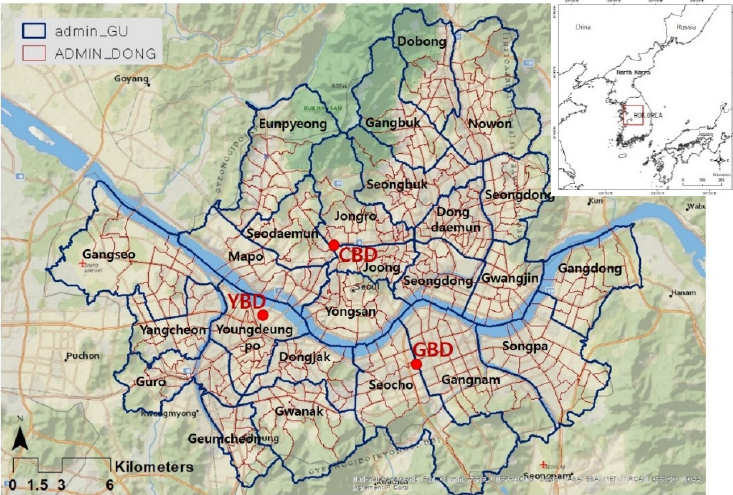
Figure 1. Map of Seoul. Note: CBD refers to a traditional business district. YBD indicates Yeoido business district, and GBD stands for Gangnam business district. These three districts are the main urban centres in Seoul [77]. The variable “admin_GU” represents 25 administrative districts and “ADMIN_DONG” refers to neighbourhood administrative districts. Source: GIS map (https://sgis.kostat.go.kr).